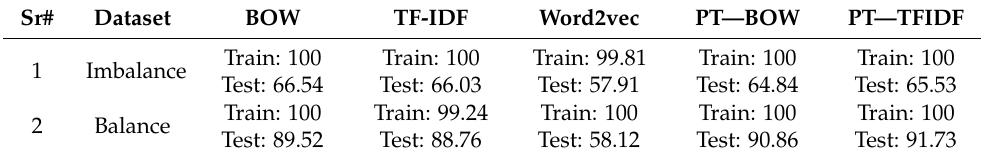
Table 5. Results of random